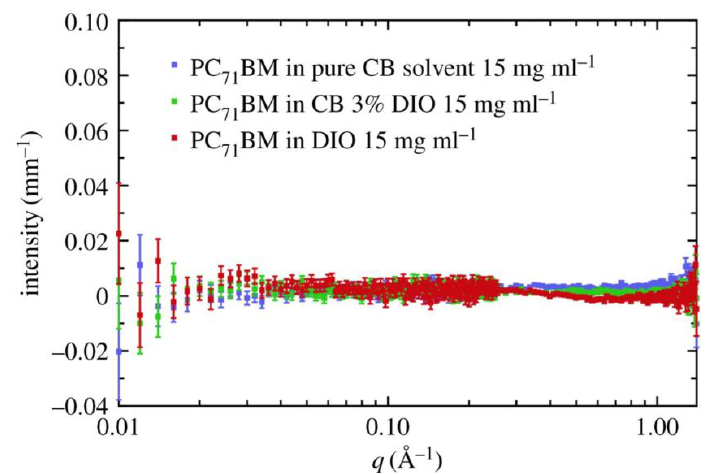
Figure 6. SANS solution data for PC 71 BM at a concentration of 15 mg mL −1 in pure CB, CB